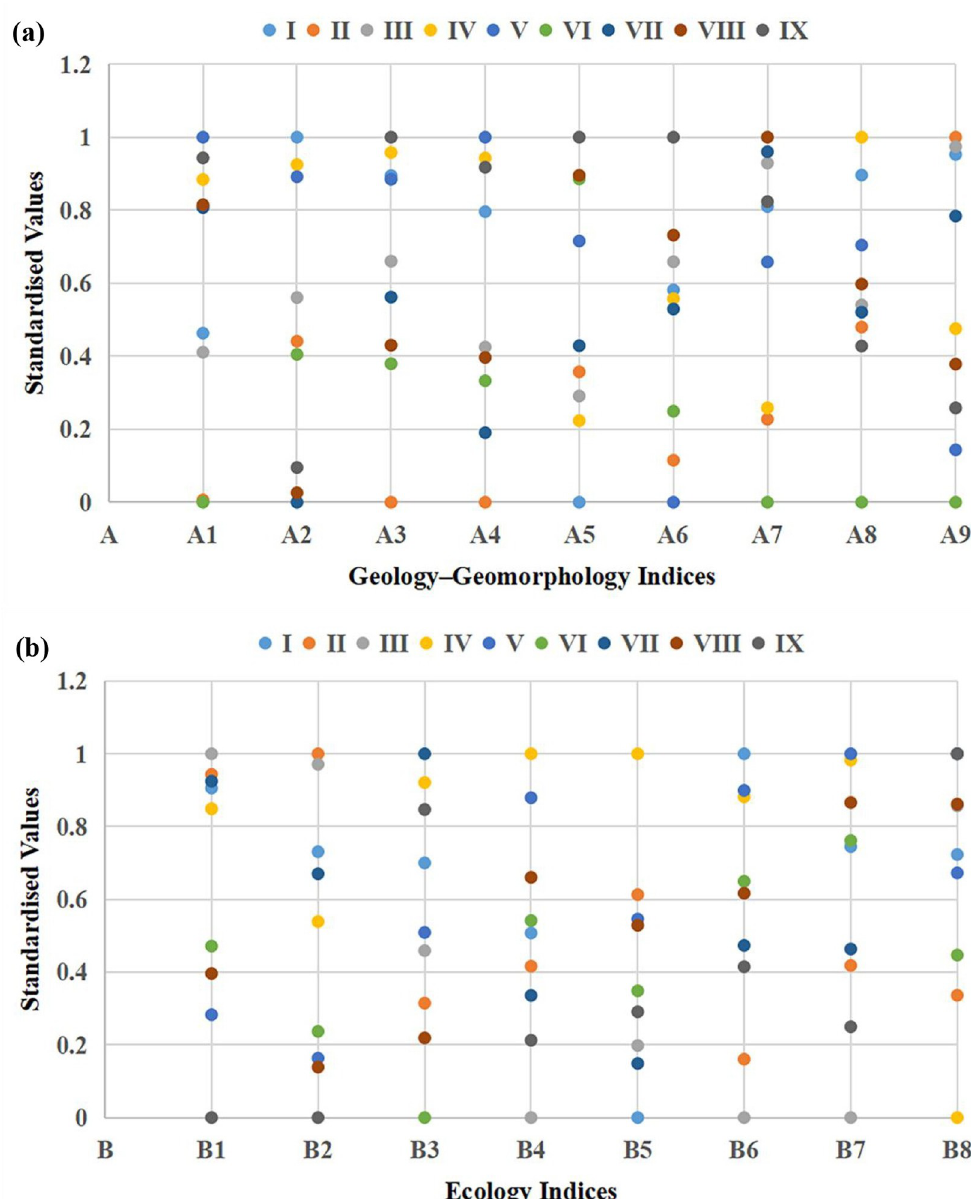
Fig 3. Standardised values of evaluation indices. (a) Geology–geomorphology indices; (b) Ecology